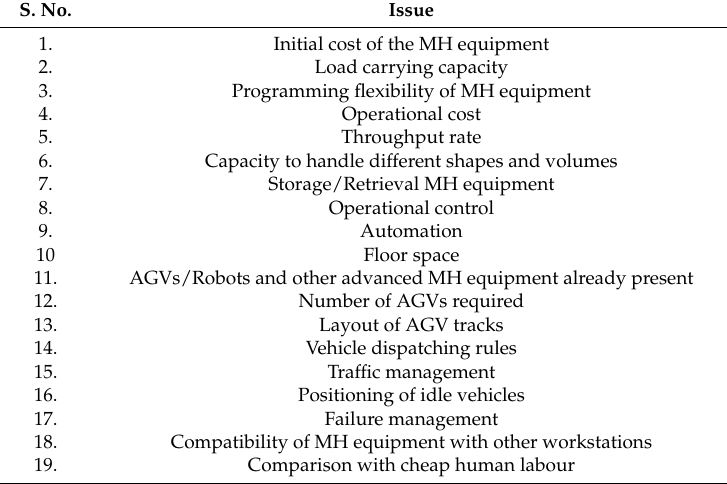
Table 1. Major issues related to the material handling equipment in